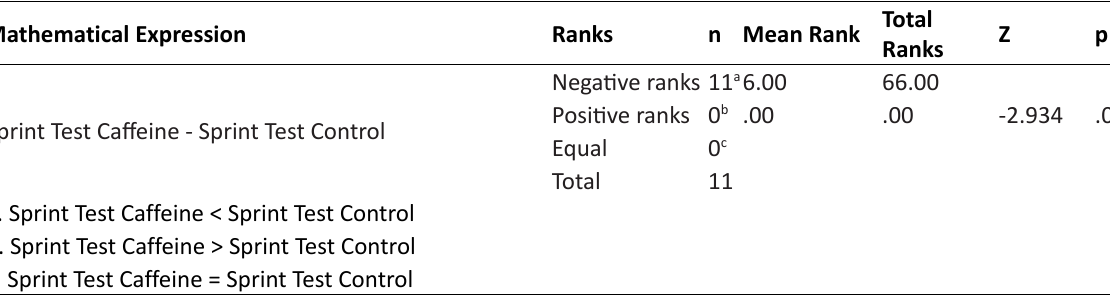
Table 8: Wilcoxon Signed Rank Analysis Results of Caffeine and Placebo Application (Sprint Test) Mathematical